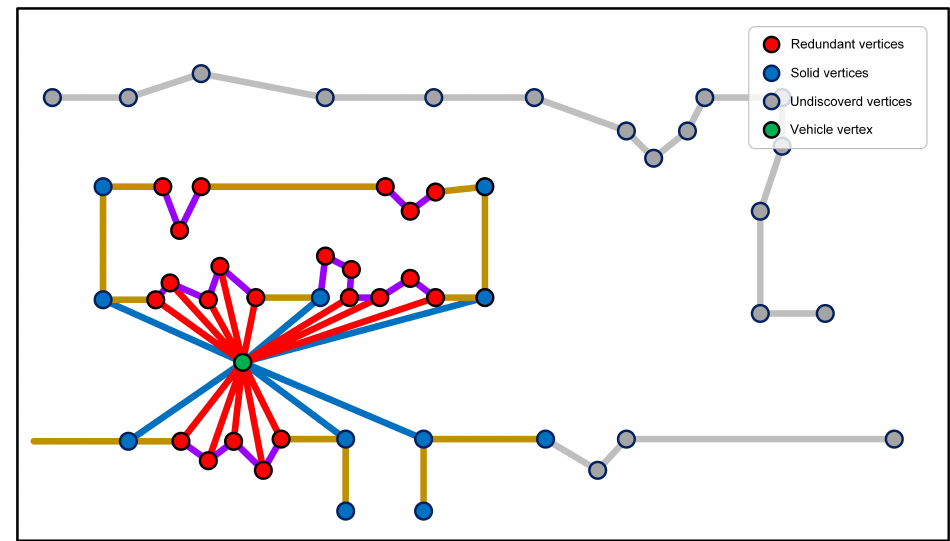
Figure 9. The red solid lines are redundant edges which connect with the robot, and the purple lines are the redundant edges from obstacles themselves.